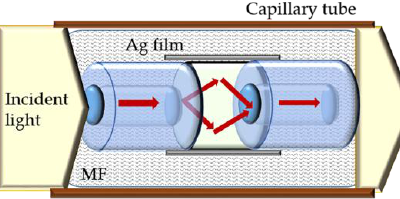
Figure 23. Schematic diagram of a magnetic field sensor based on a MNF structure (adapted